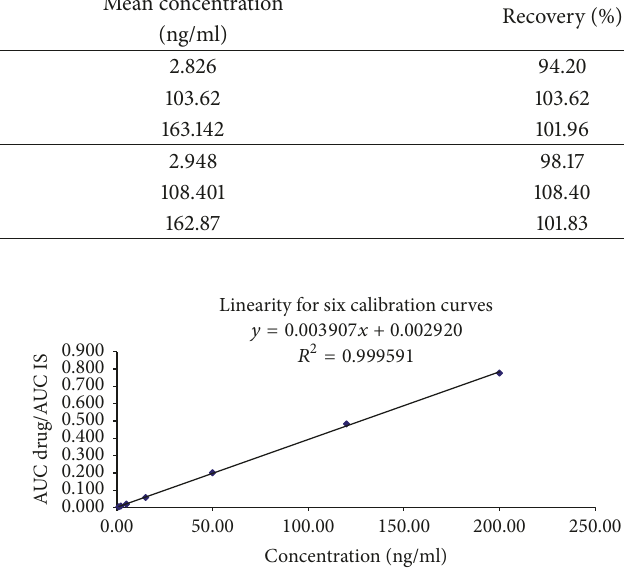
Figure 3: Calibration curve of peak area versus concentration (ng/ml) for enalapril.